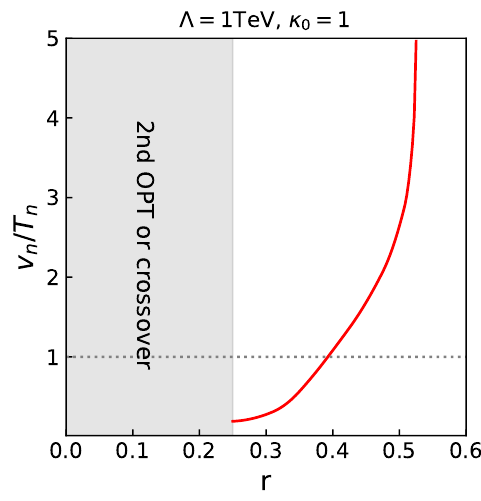
Figure 1 . The relation between v n /T n and the non-decouplingness r . We take Λ = 1 TeV and κ 0 = 1